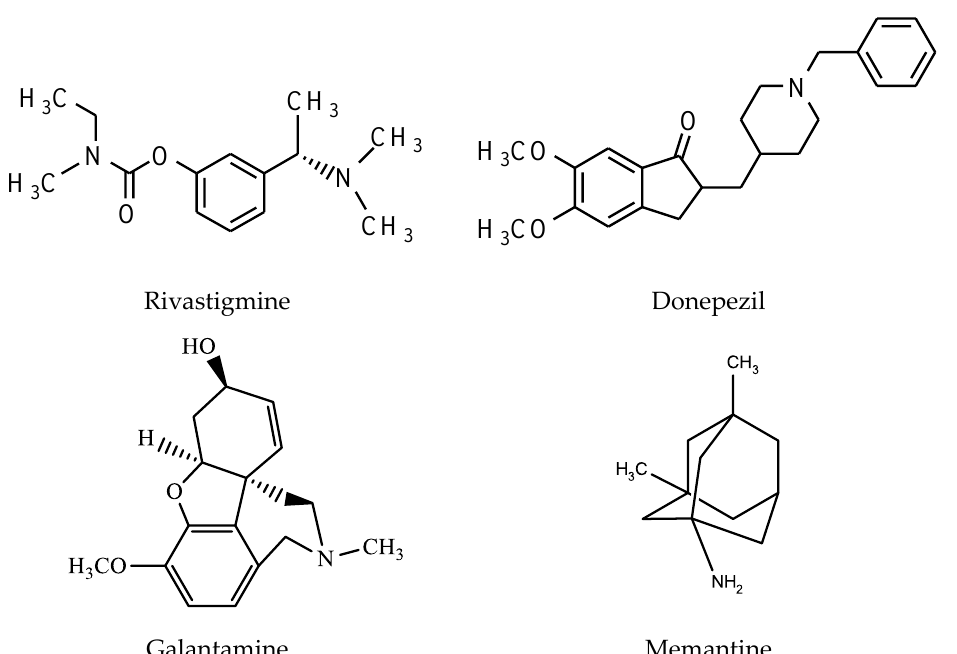
Figure 1. The main drugs and their chemical structure approved in the treatment of Alzheimer ’ s disease.